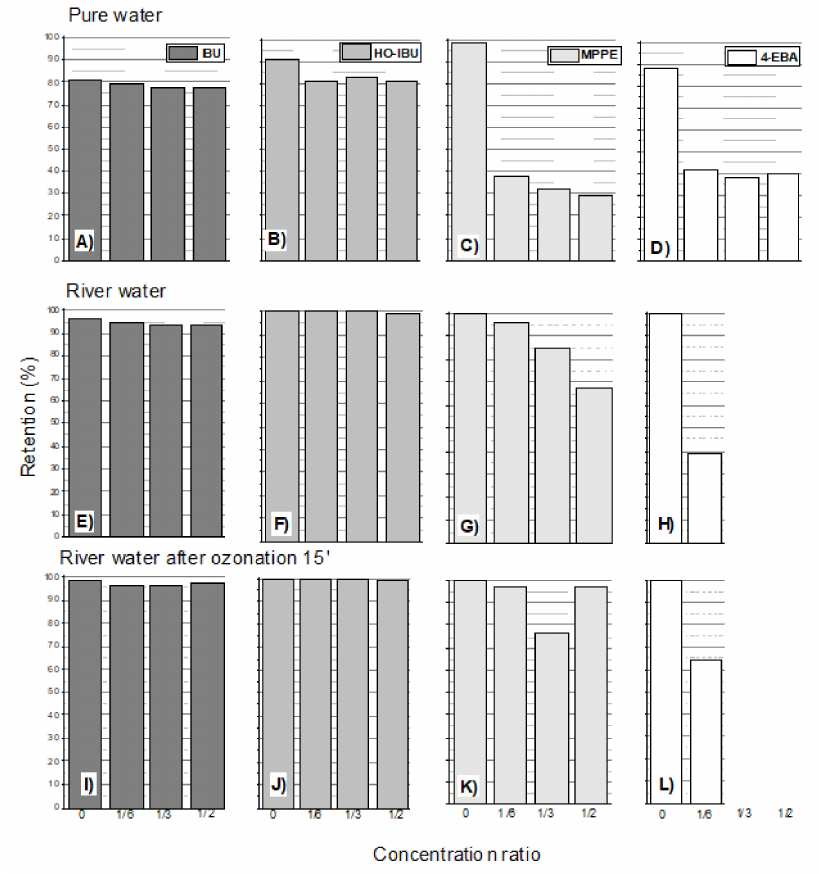
Figure 5. The influence of the water matrix on the retention of IBU oxidation products: ( A ) Ibuor- fen (IBU) in pure water; ( B ) 41-hydroxyibuprofen (OH-IBU) in river water; ( C ) 1-(4-isobutyl- phenyl)ethanol (MPPE) in pure water; ( D ) 4-Ethylbenzaldehyde (4-EBA) in pure water; E ) IBU in river water; ( F ) OH-IBU in river water; ( G ) MPPE in river water; ( H ) 4-EBA in river water; ( I ) IBU in river water ozonated for 15 min (ozone dose in the gas phase: 31.5 mg O 3 per L of water); ( J ) OH- IBU in river water ozonated for 15 min (ozone dose in the gas phase: 31.5 mg O 3 per L of water); ( K ) MPPE in river water ozonated for 15 min (ozone dose in the gas phase: 31.5 mg O 3 per L of water); ( L ) 4-EBA in river water ozonated for 15 min (ozone dose in the gas phase: 31.5 mg O 3 per L of water); membrane HL, pressure 1.0 MPa, temp. 30 ◦ C. See Table 1 for the composition of the river water